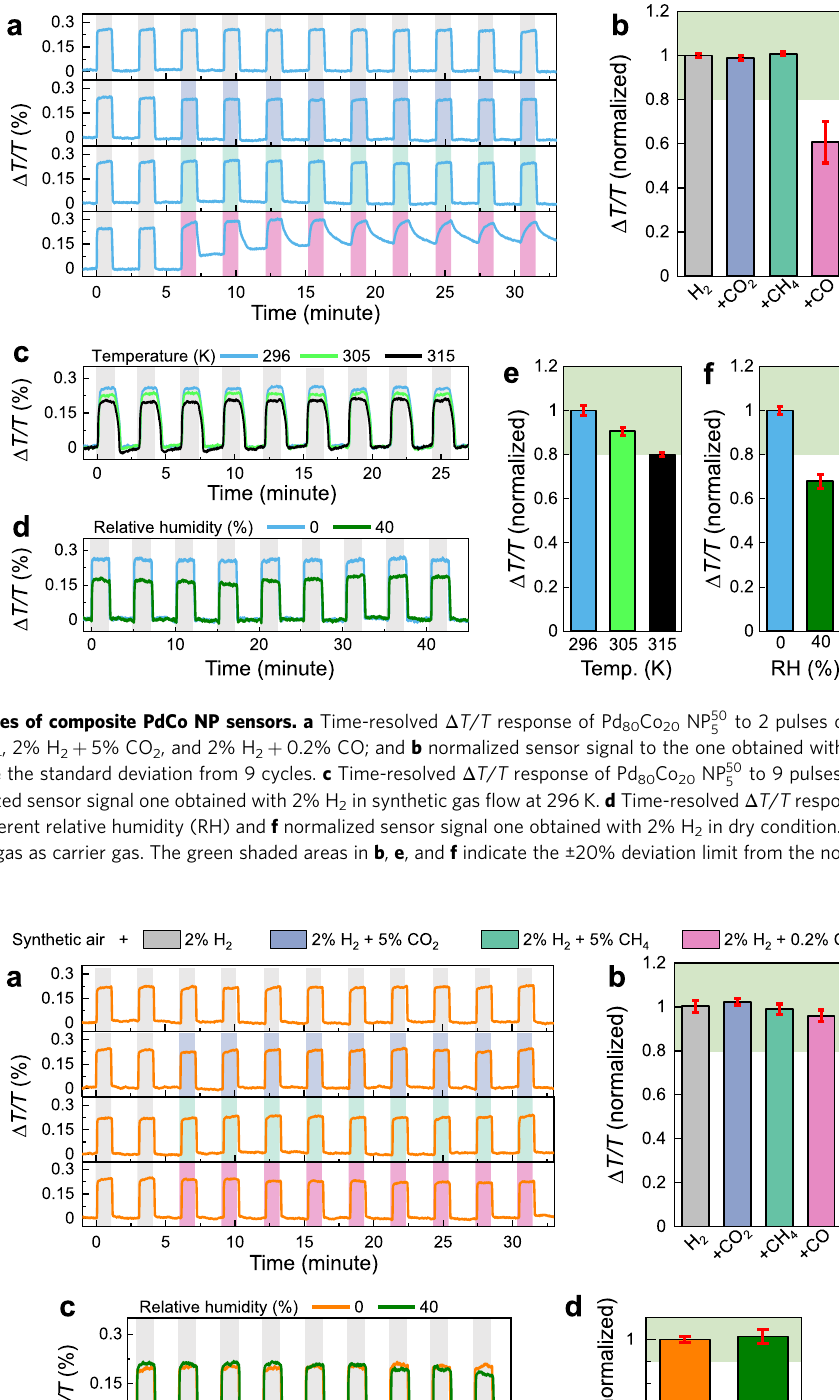
Fig. 7 Sensing performances of composite PdCo NP/PMMA sensors. a Time-resolved Δ T / T response of Pd 80 Co 20 NP 50 followed by 9 pulses of 2% H 2 + 5% CH 4 , 2% H 2 + 5% CO 2 , and 2% H 2 + 0.2% CO; and b normalized sensor signal to the one obtained with 2% H 2 in synthetic gas fl ow. The error bars denote the standard deviation from 9 cycles. c Time-resolved Δ T / T response of Pd 80 Co 20 NP 50 2% H 2 with different RH and d normalized sensor signal one obtained with 2% H 2 in dry condition. All measurements were performed using synthetic gas as carrier gas. The green shaded areas in b and d indicate the ±20% deviation limit from the normalized Δ T / T response with 2% H 2